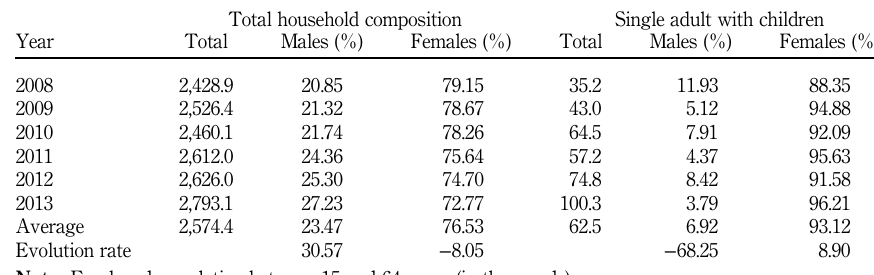
Table I. Employed persons working part-time in